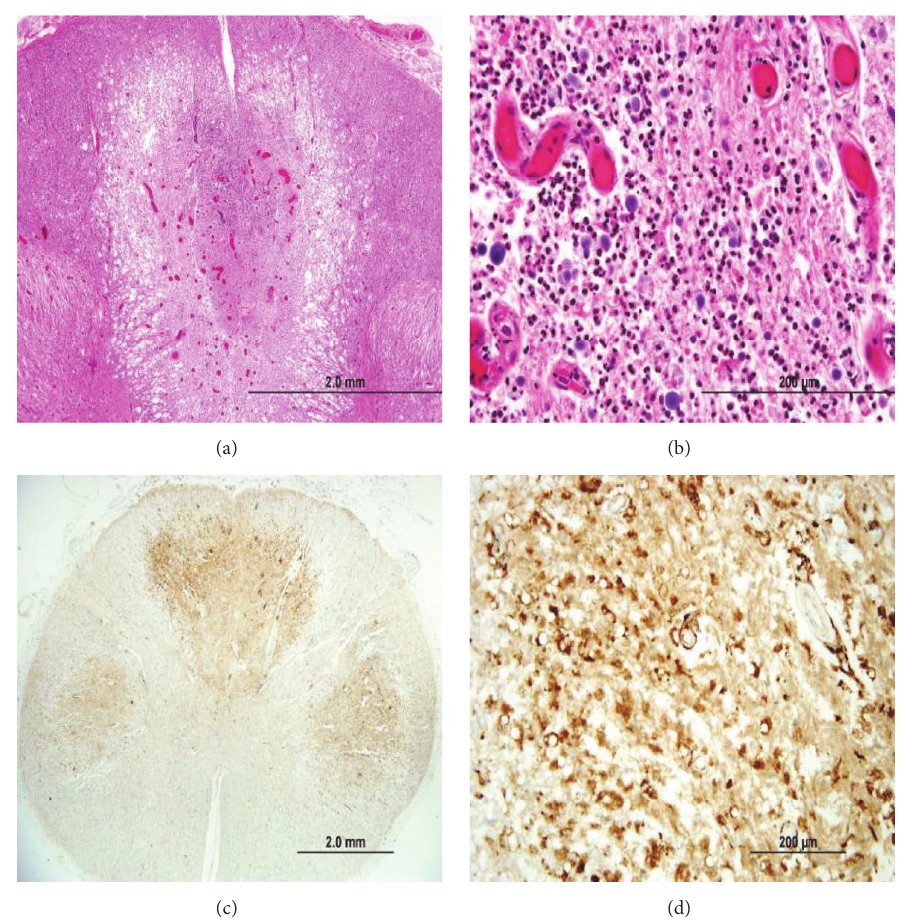
Figure 2: Acute and subacute ischemic changes in the spinal cord. (a, b) Intermediate-power and high-power photomicrographs of dorsal columns in a section with neutrophilic infiltrates and reactive vessels (original magnifications, × 40 and × 400, resp.; H-E stain); (c) low- power photomicrograph of spinal cord stained with antibody against CD68 to demonstrate foamy macrophages and microglia, primarily within dorsal columns and lateral white matter tracts (original magnification, × 20; CD68 immunostain); (d) higher-power photomicrograph of the dorsal columns showing CD68-positive macrophages and microglia (original magnification, × 200; CD68